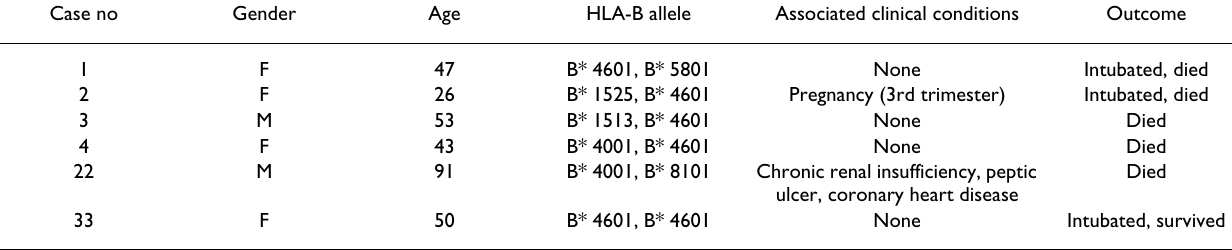
Table 3: HLA-B* 4601 allele and 6 deceased or intubated probable SARS